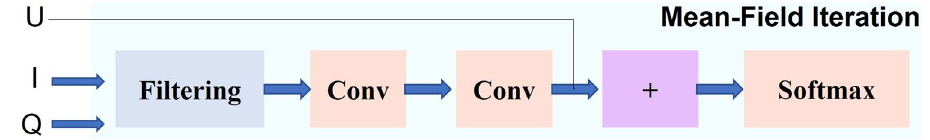
Figure 5. Updated equation for the mean-field inference of 36 decomposed into smaller steps, where one iteration can be seen as a neural